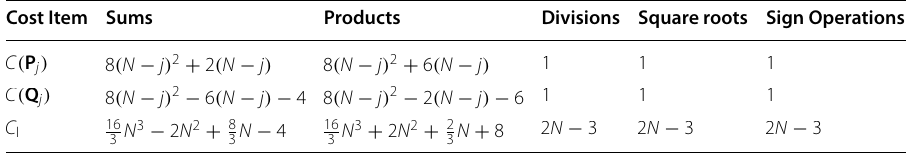
Table 3 Bidiagonalization computational cost Cost Item Sums Products Divisions Square roots Sign